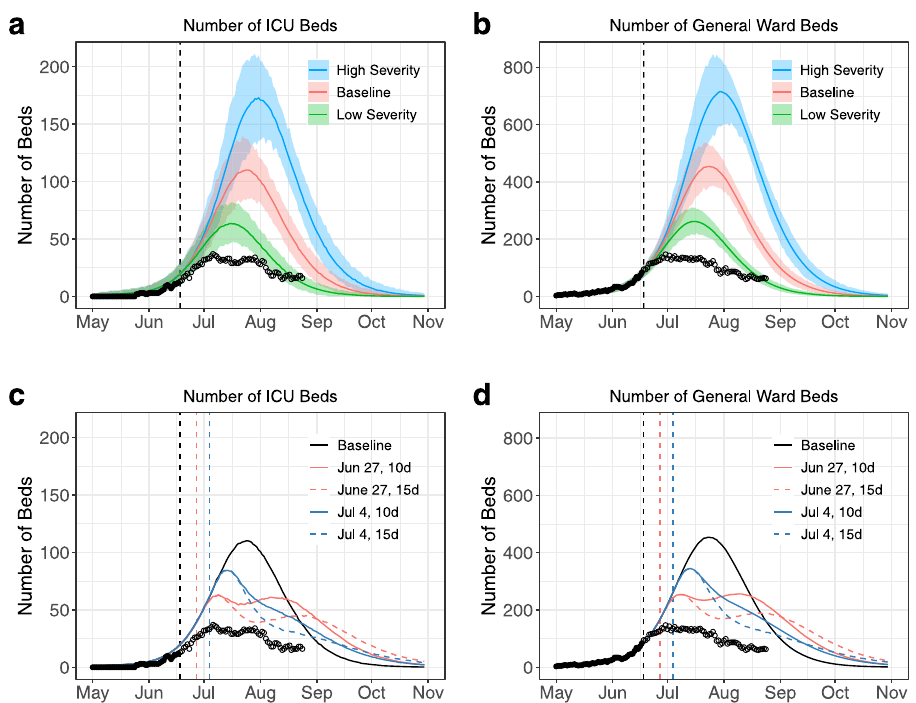
Fig. 2 Analyses made on June 18th 2020 describing a scenario with no change in transmission rates and the impact of a short-term lockdown. a , b Projections for the number of ICU and general ward beds required under different severity scenarios (baseline in red, low severity in green, high severity in blue). Solid lines indicate model posterior means while colour areas indicate 95% credible intervals. c and d Projections for the average number of ICU and general ward beds required under different territory-wide lockdown scenarios (black represents our baseline model, red represents lockdowns starting on June 27th, blue represents lockdowns starting on July 4th, solid lines correspond to lockdowns lasting for 10 days, while dashed lines correspond to lockdowns lasting for 15 days). In all panels, black dots indicate data used to calibrate the models, while empty circles denote data not available at the time of the analyses. The black dashed line in all panels indicates the date of the analyses (June 18th). The coloured dashed lines in panels c and d indicate the start of the simulated lockdown (red for June 27th and blue for July